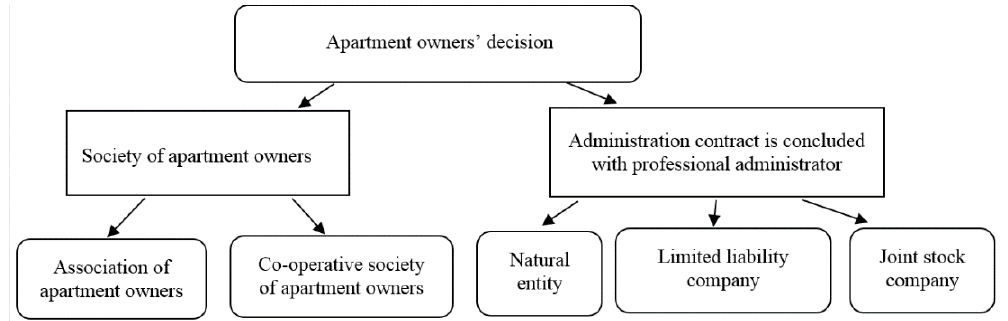
Fig. 1. The process of residential housing management and its organisation [developed by the